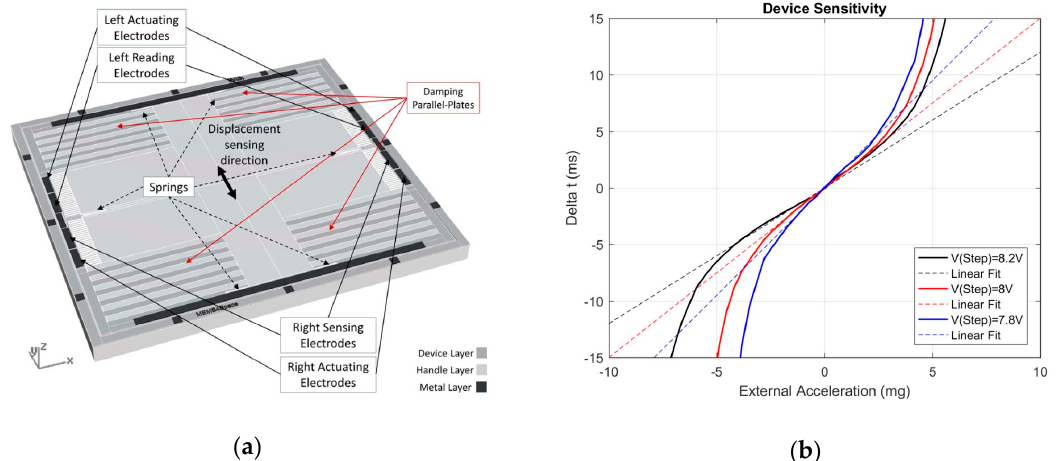
Figure 23. Schematic diagrams of the MEMS accelerometer by Garcia et al. at University of Minho and its sensitivity [132]: ( a ) MEMS accelerometer, ( b ) measured sensitivity.